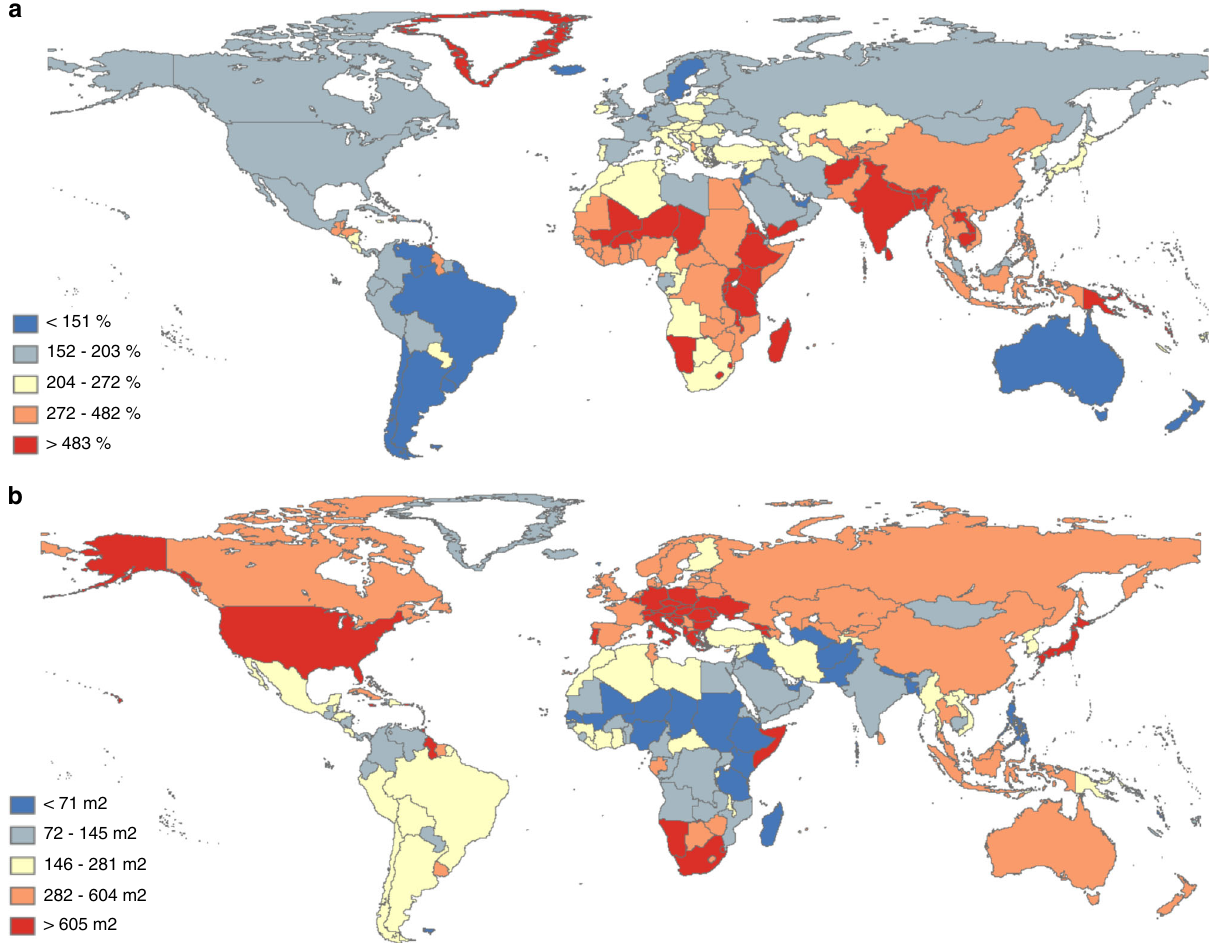
Fig. 2 National urban land expansion in the middle of the road scenario. a Global quintile map of urban land expansion rate (%) 2000 – 2100. b Global quintile map of per capita urban land area (m 2 ) in 2100 (this variable in 2000 is shown in Supplementary Fig. 1). (Source data are provided as a Source Data fi